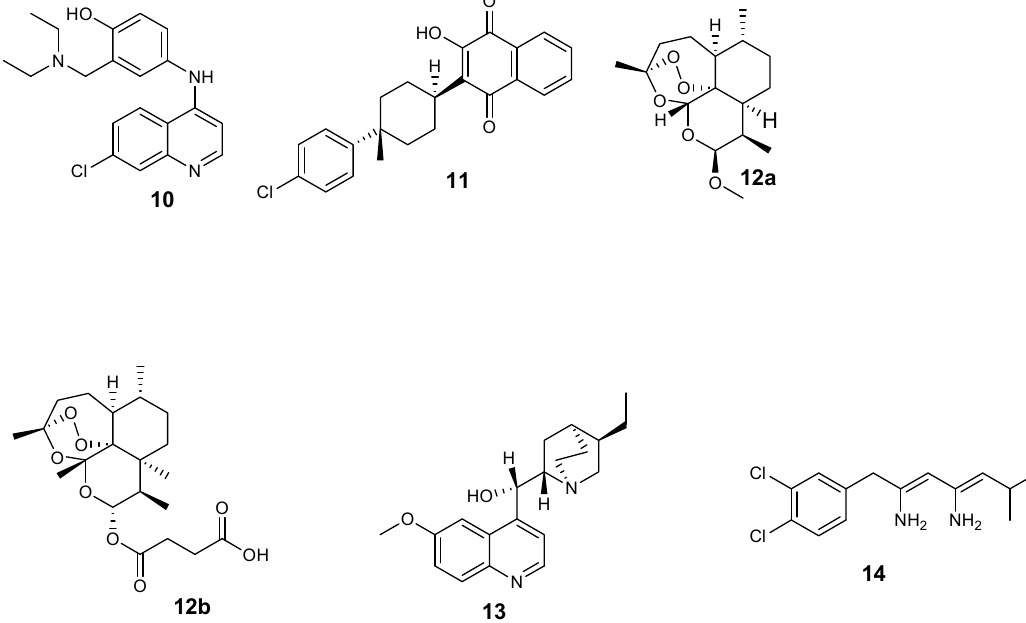
Figure 2. Structure of antimalarial drugs classified based on their chemical structures.